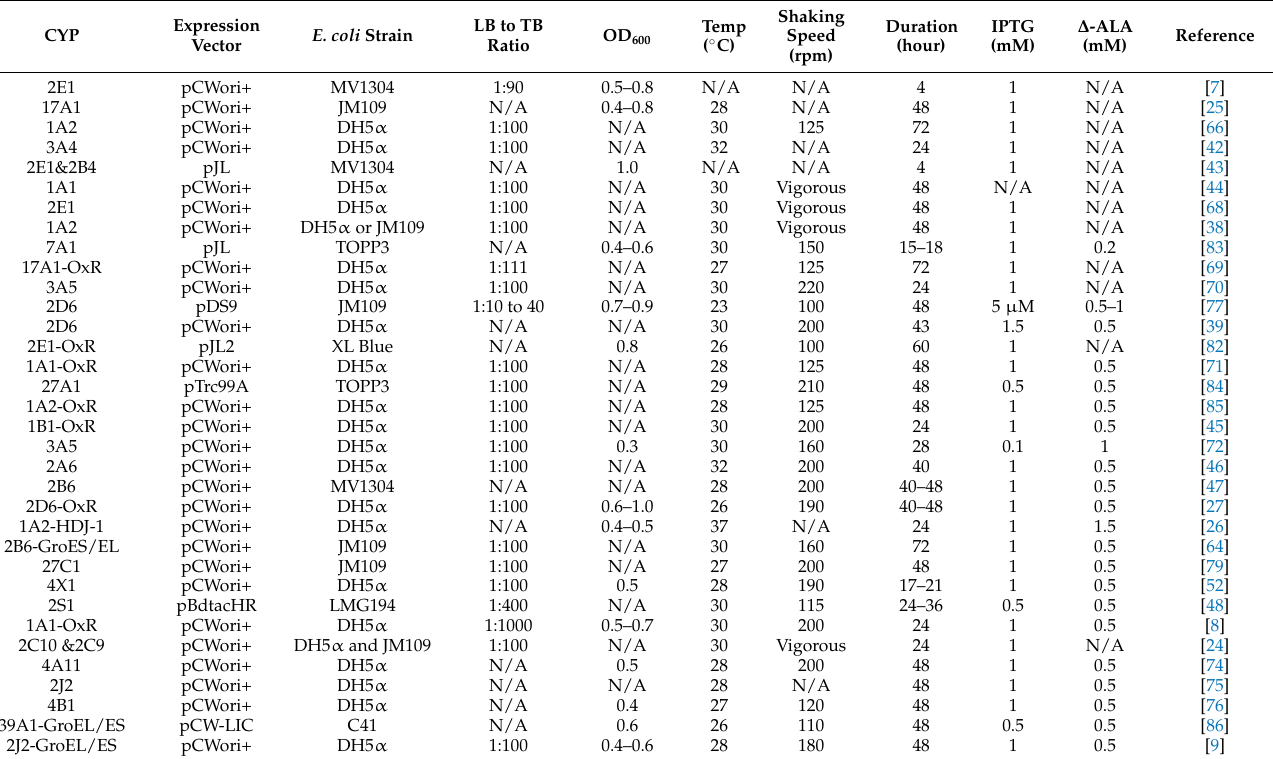
Table 1. External contributing factors for selected human CYP expression in E. coli